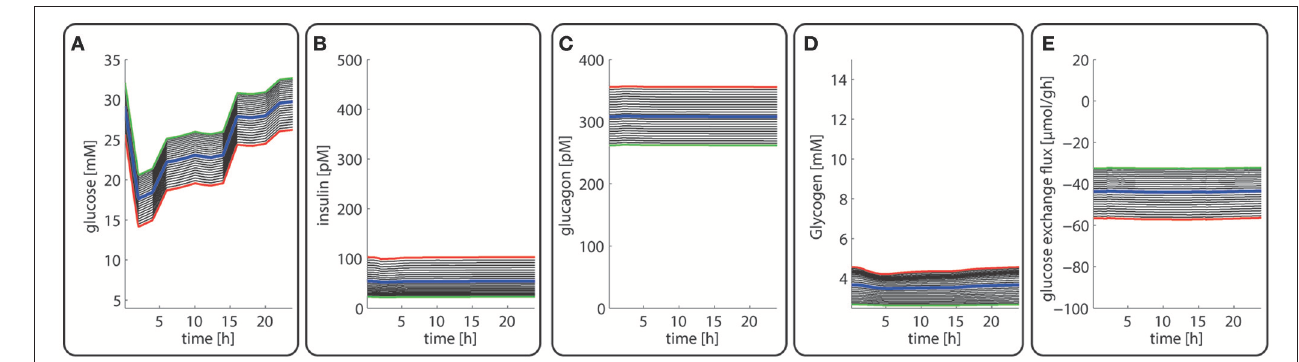
FIGURE 9 | Diurnal variations in the plasma levels of glucose (A) , insulin (B) , glucagon (C) , cellular glycogen (D), and the glucose exchange flux (E) in different zones along the porto-central axis of a diabetic rat.